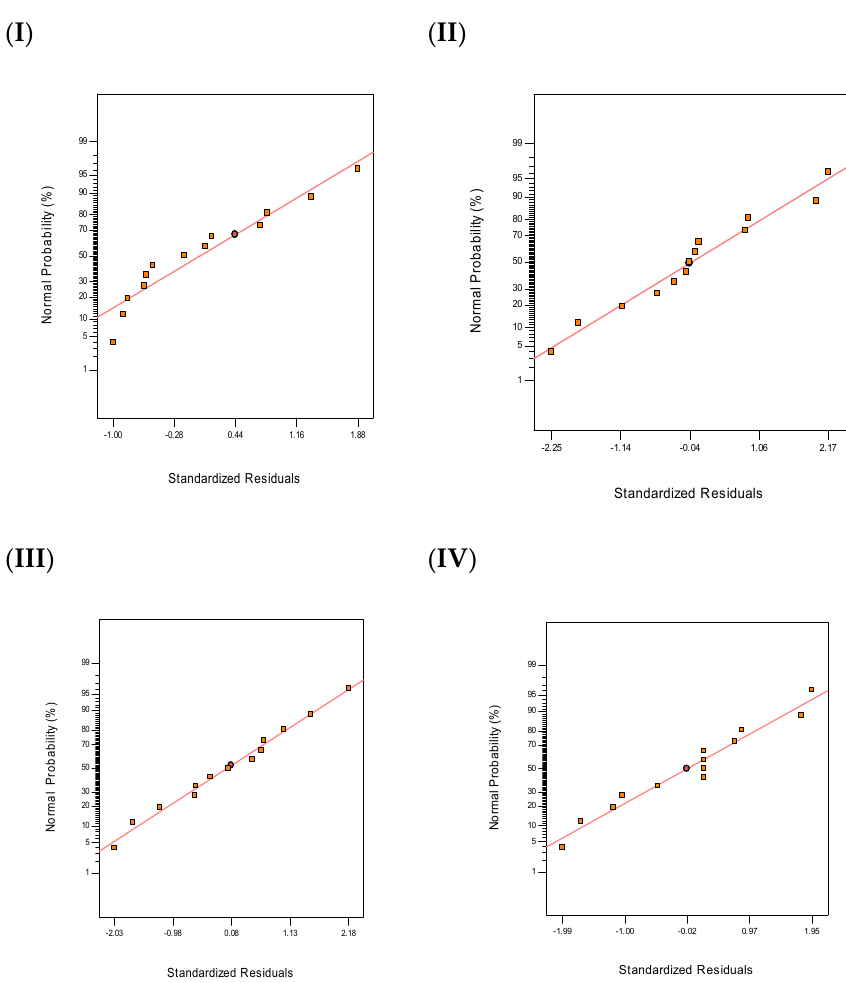
Figure 6. Normal probability plots for ( I ) COD, ( II ) TSS, ( III ) color, and ( IV ) NH 3 -N removal.